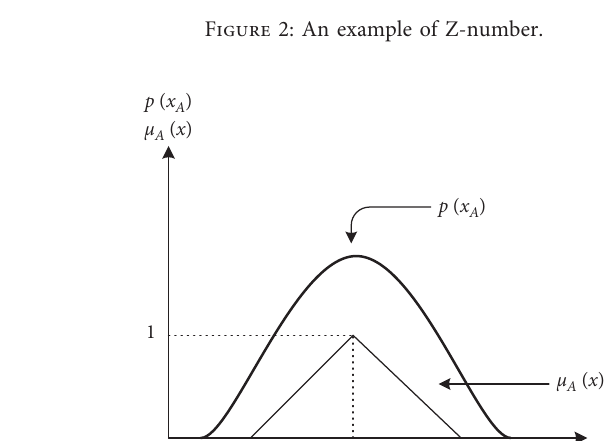
Figure 2: An example of Z-number.